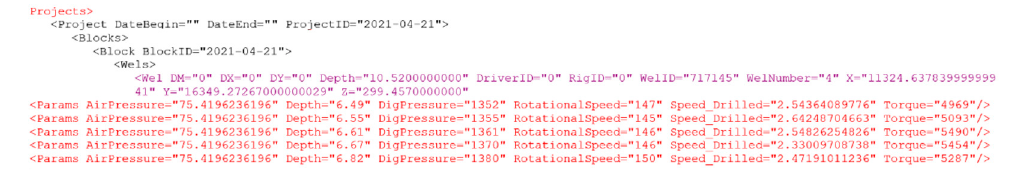
Figure 4. Content of the XML file with output parameters of the borehole drilling process.